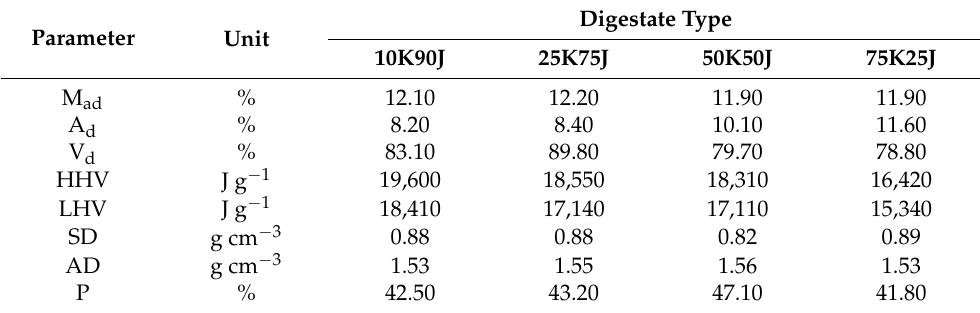
Table 2. Physical properties of tested mixtures of post-fermentation biomass